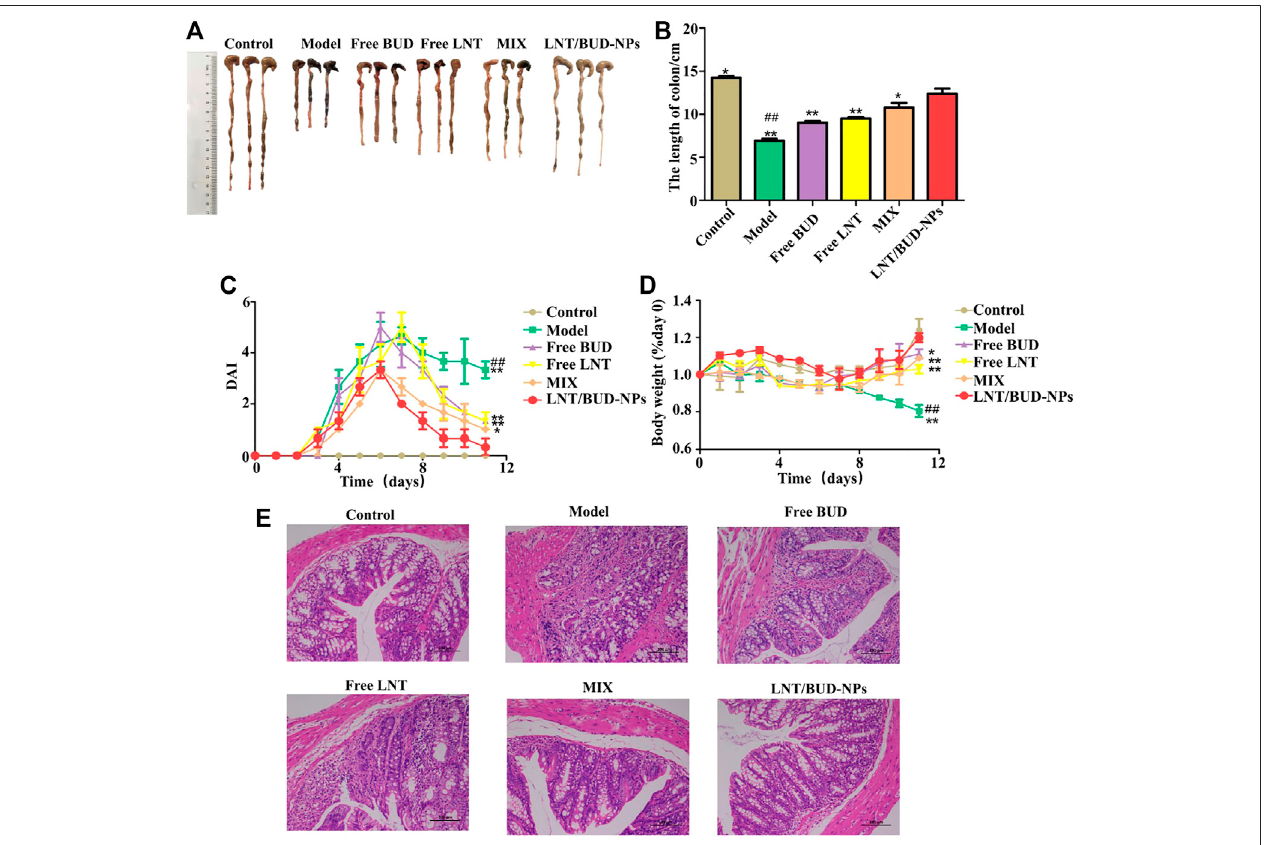
FIGURE 5 | In vivo therapeutic ef fi ciency of different formulas to DSS-induced UC in a mouse model. (A) Colon images of different formulas after treatment with different formulas, including Free LNT, Free BUD, MIX, and LNT/BUD-NPs. (B) Histogram analysis of colon length of mice from the different formulas. (C) Graph of DAI scores over time from the different formulas. (D) Graph of body weight over time from the different formulas. (E) H&E staining of colonic sections from the different formulas. * p < 0.05, ** p < 0.01 vs. LNT/BUD-NPs; # p < 0.05, ## p < 0.01 vs. Model; n (cid:1)